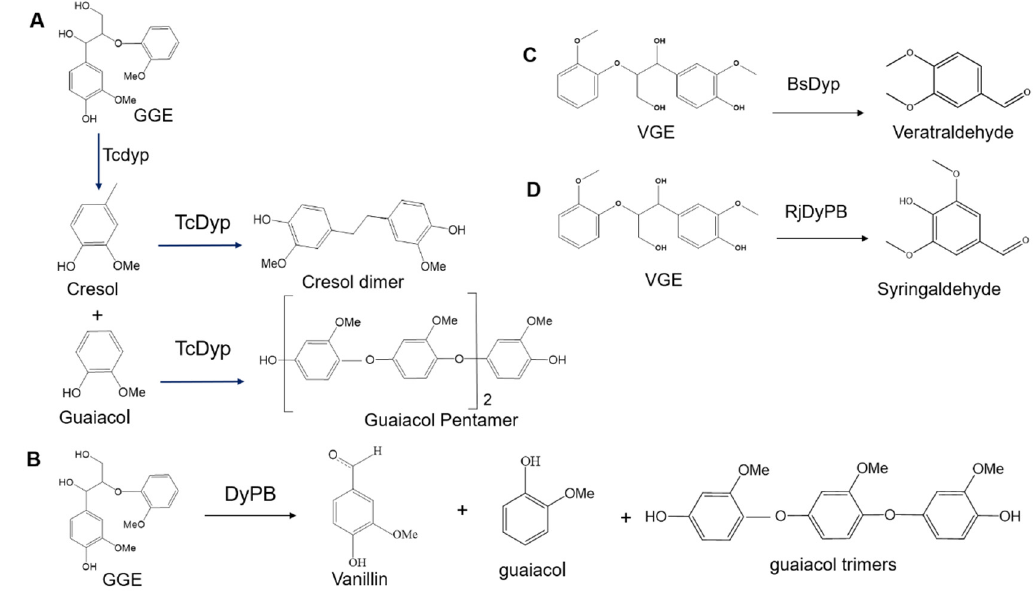
Figure 3. Lignin degradation reactions were listed. ( A ) tcDyP Degradation of GGE by TcDyP to produce a polymer. ( B ) Degradation of GGE to vanillin by DyPB. ( C ) Degradation of VGE to Veratraldehyde by BsDyP. ( D ) Degradation of VGE to Syringaldehyde by TfuDyP.